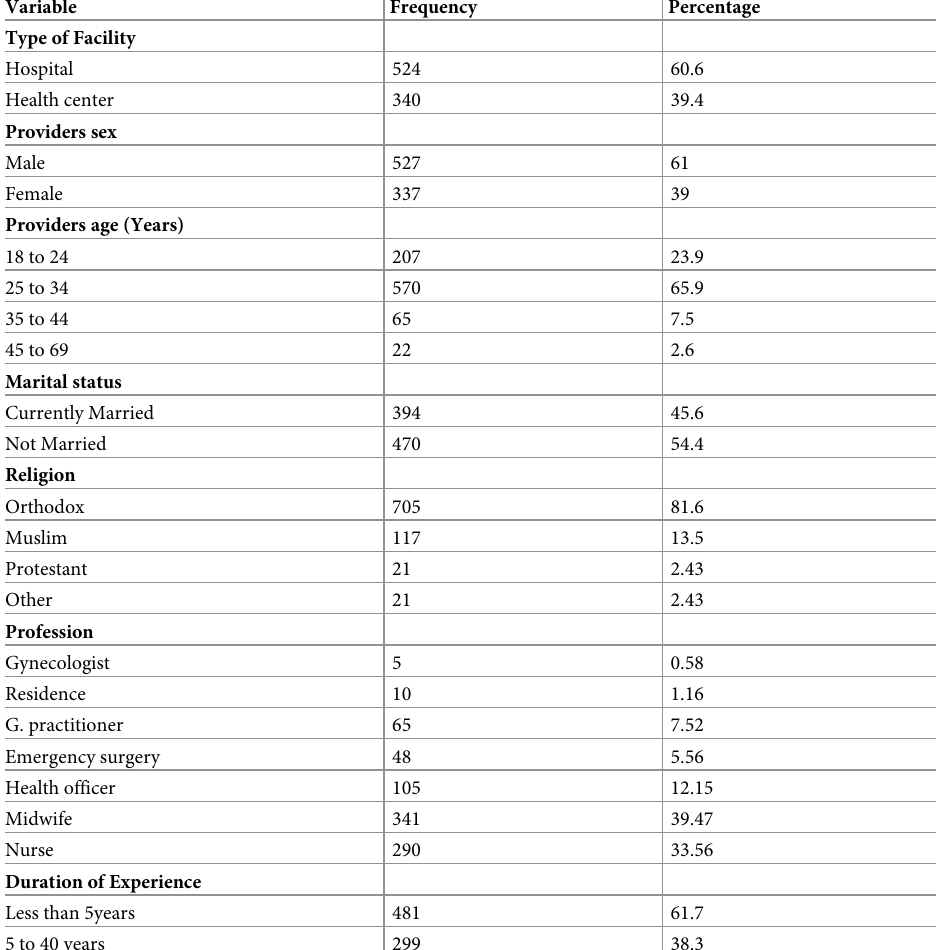
Table 1. Socio-demographic characteristics of the study population by health facility in Amhara regional state, Ethiopia, 2016. Variable Frequency